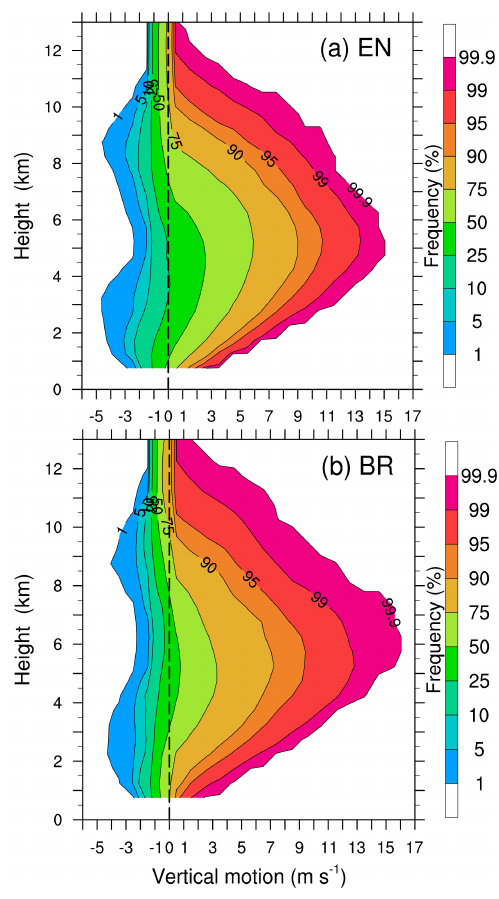
Figure 8. CCFADs of the simulated vertical motion for (a) the EN scheme and (b) the BR scheme within the respective boxes marked with pink lines in Fig. 6. The CCFADs are calculated from 11 model outputs with 6min intervals during the severe rainfall episode from 06:00 to 07:00BST 7 May